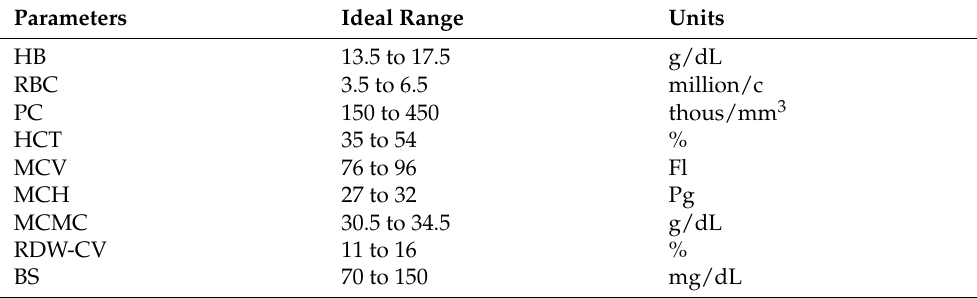
Table 2. Blood Report Parameters and their ideal range with measuring units.